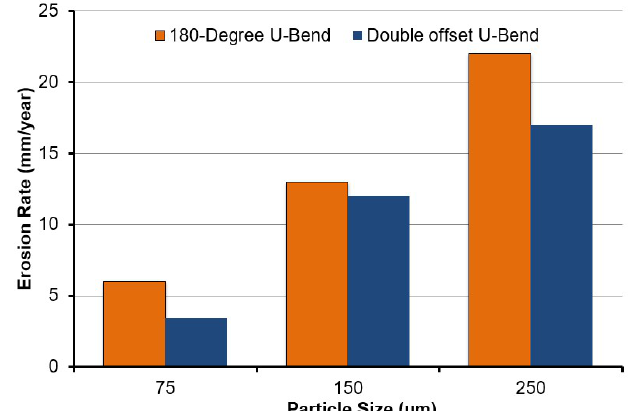
Figure 15. Maximum erosion rate in 180° U-bend and double offset U-bend for three different particle sizes.